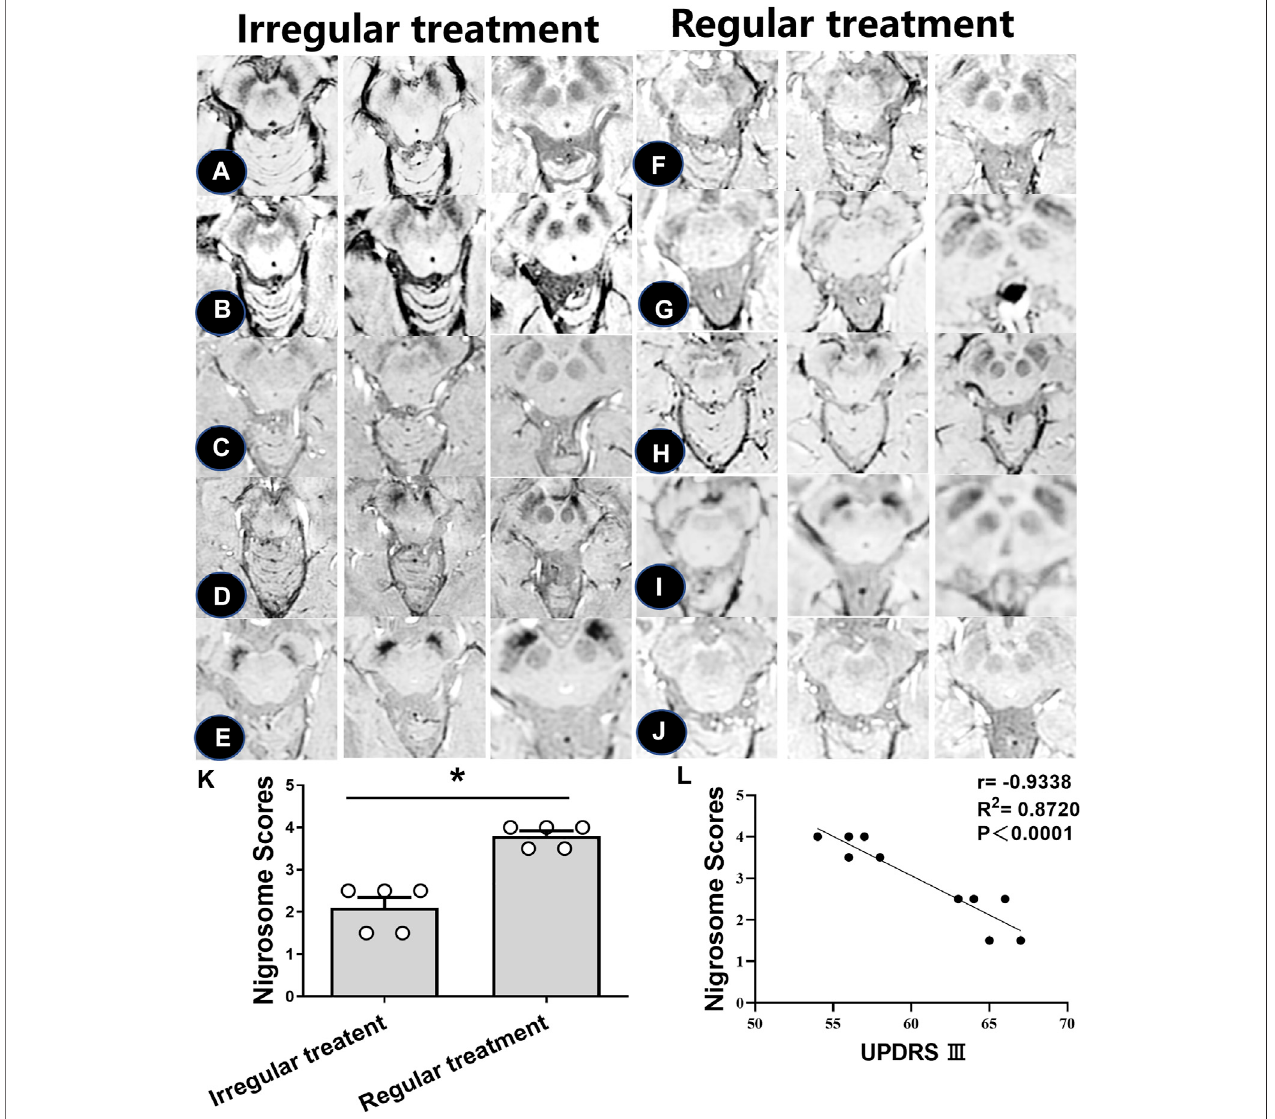
FIGURE 4 | Iron accumulation in the nigrosome with regular and irregular treatments. (A – J) . SWI images of 10 PD patients receiving irregular or regular levodopa treatment. (K) Mean scores of the nigrosome was increased with regular treatment compared with irregular treatment; * compared with irregular treatment, p < 0.05. (L) Correlation analysis was used to reveal the relationship between UPDRS Ⅲ scores and nigrosome scores.